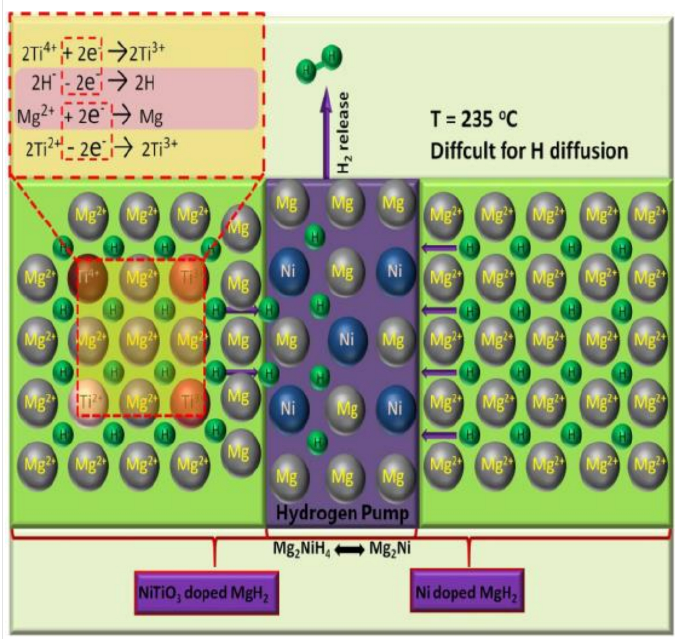
Figure 38. Schematic diagram of the catalytic mechanism of Ti and Ni in MgH 2 hydrogen storage system. Reproduced with permission [214]. Copyright 2018, American Chemical